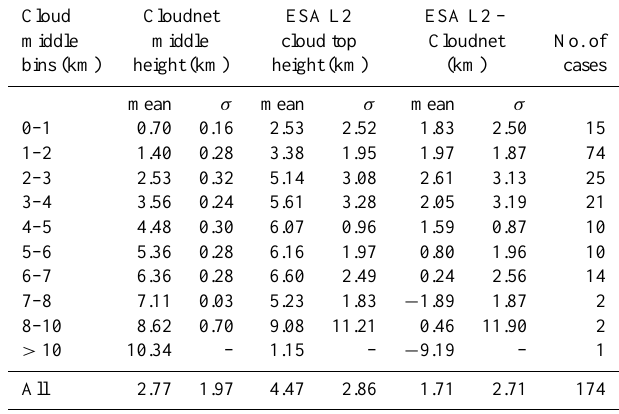
Table A4. Comparison of SCIAMACHY ESA L2 cloud top height with Cloudnet cloud middle height for single-layer clouds.